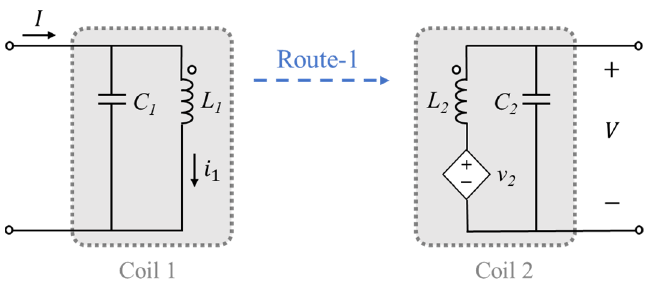
Figure 2. The equivalent circuit model of two coils with Route 1.